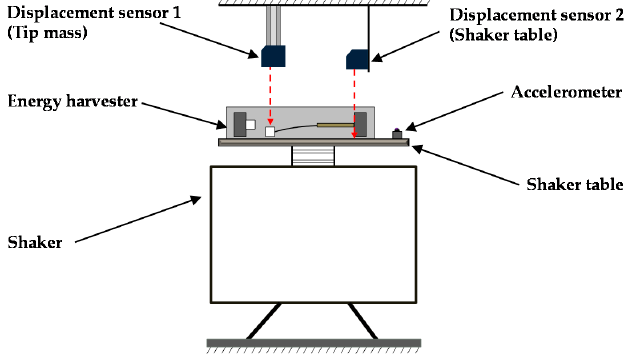
Figure 5. Schematic diagram of the experimental setup.